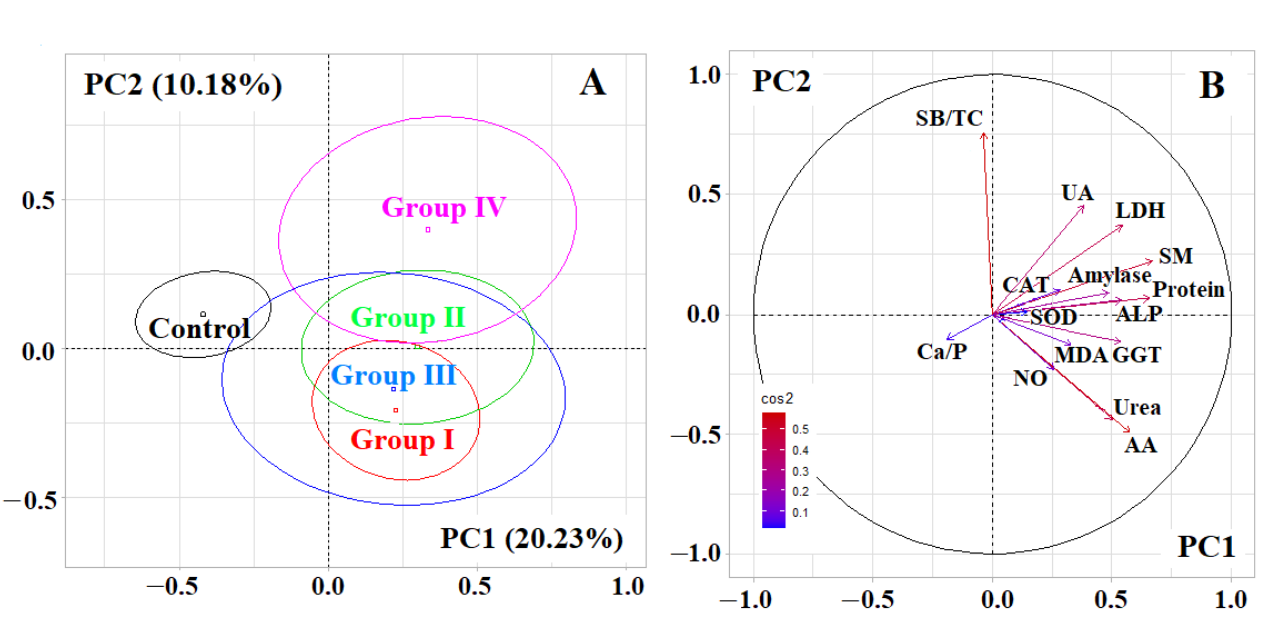
Figure 2. ( A ) — Individuals factor map (PCA); ( B ) — Variables factor map. UA — uric acid, LDH